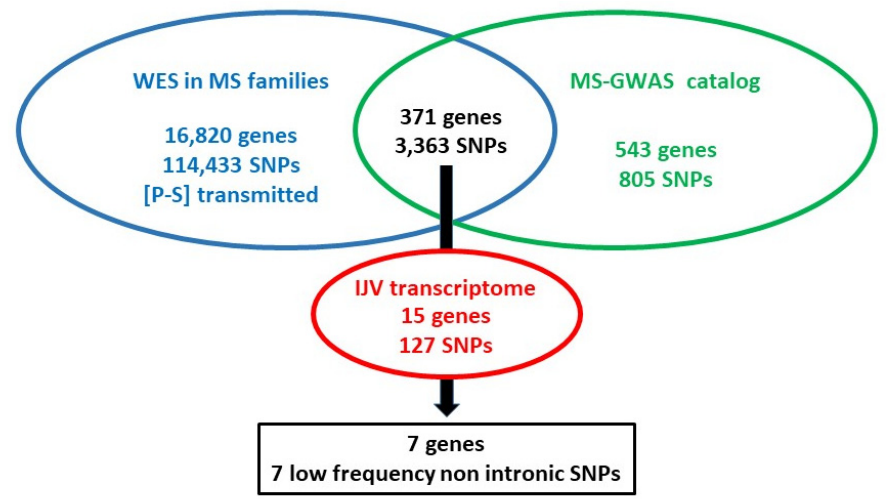
Figure 3. Schematic representation of the filtering approaches to prioritize SNPs. Variants with vertical transmission of disease within the MS families (WES output, blue) were selected and then filtered using both MS-GWAS (green) and transcriptomic (red) datasets.